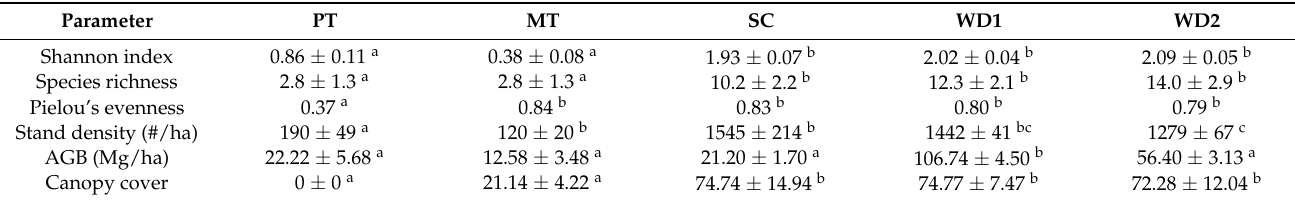
Table 1. Stand characteristics, floristics diversity, aboveground biomass (AGB), and canopy cover variation in five land use categories (PT—productive tea, MT—marginal tea, SC—scrub, WD1, and WD2) along a successional chrono-sequence in the tropical secondary lowland rainforest in the Endane Biodiversity Corridor, Dilmah Conservation and Kahawatte Plantations PLC., located close to the Sinharaja Rainforest Complex in the Rathnapura District of Sri Lanka. Comparisons depicted by the different letters indicate significant pair-wise differences at the 95% confidence level.